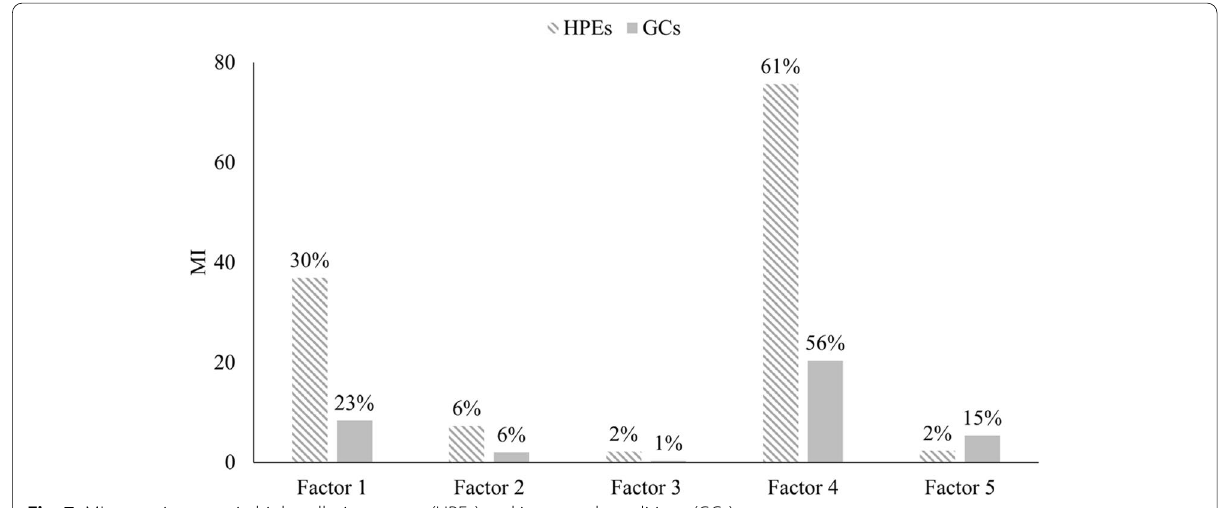
Fig. 7 MI apportionment in high pollution events (HPEs) and in general conditions